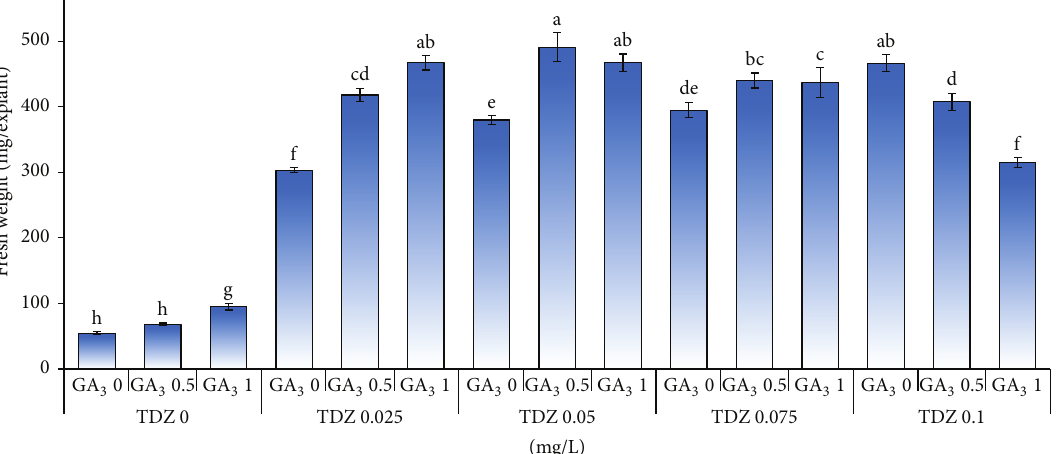
Figure 7: Effect of different concentrations of TDZ (mg/L) in combination with GA 3 (mg/L) on fresh weight of shoots produced per explants of tea clone Iran 100.